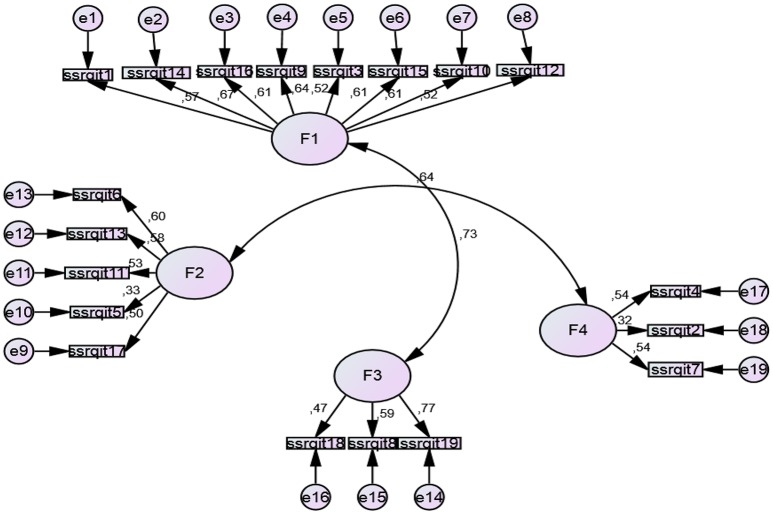
Confirmatory structural analysis of SSRQ (n = 365). For the items, see Annex II in Supplementary Meterial.